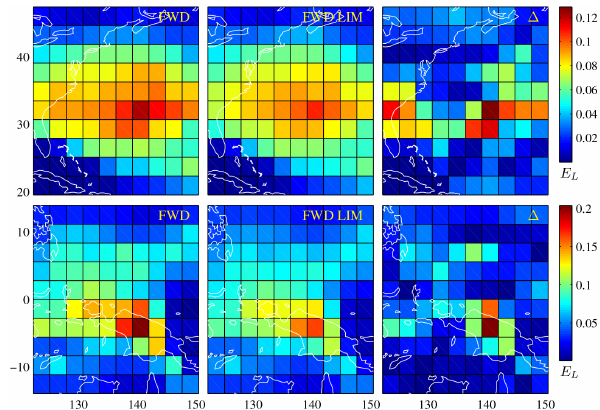
Figure 4. Comparison of direct sensitivities calculated with and without nonlinear flux limiting for test cases I (top) and II (bottom). The left hand plots repeat the direct sensitivity results previously shown in Figs. 1b and 2b whereas the centre plots show the same direct sensitivity calculated with flux limiters turned on. Note that the colour scales for the four left-hand plots are as used in Figs. 1a– b (top) and 2a–b (bottom). The colour scales shown here are for the right-hand plots, which give the size of the relative error between the direct sensitivity calculated with and without flux